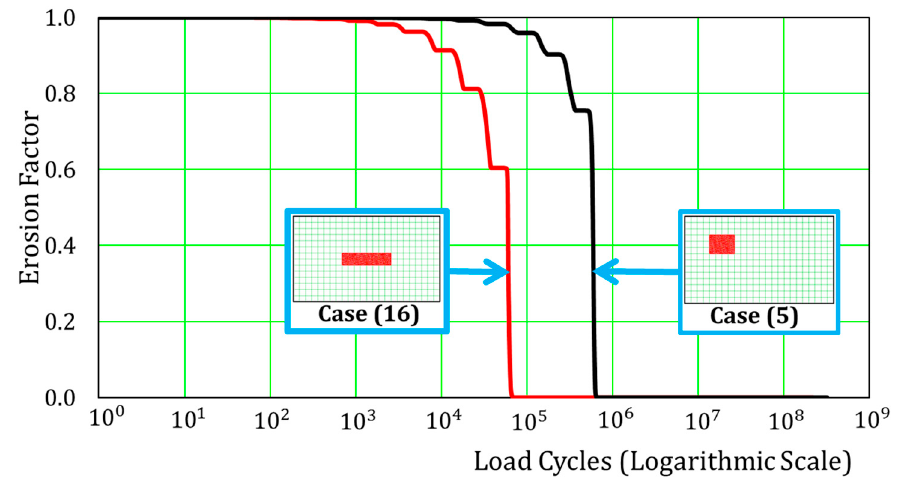
Figure 18. Load cycles and the erosion factor of the upper zone of cases (5) and (16) at their wetting locations.